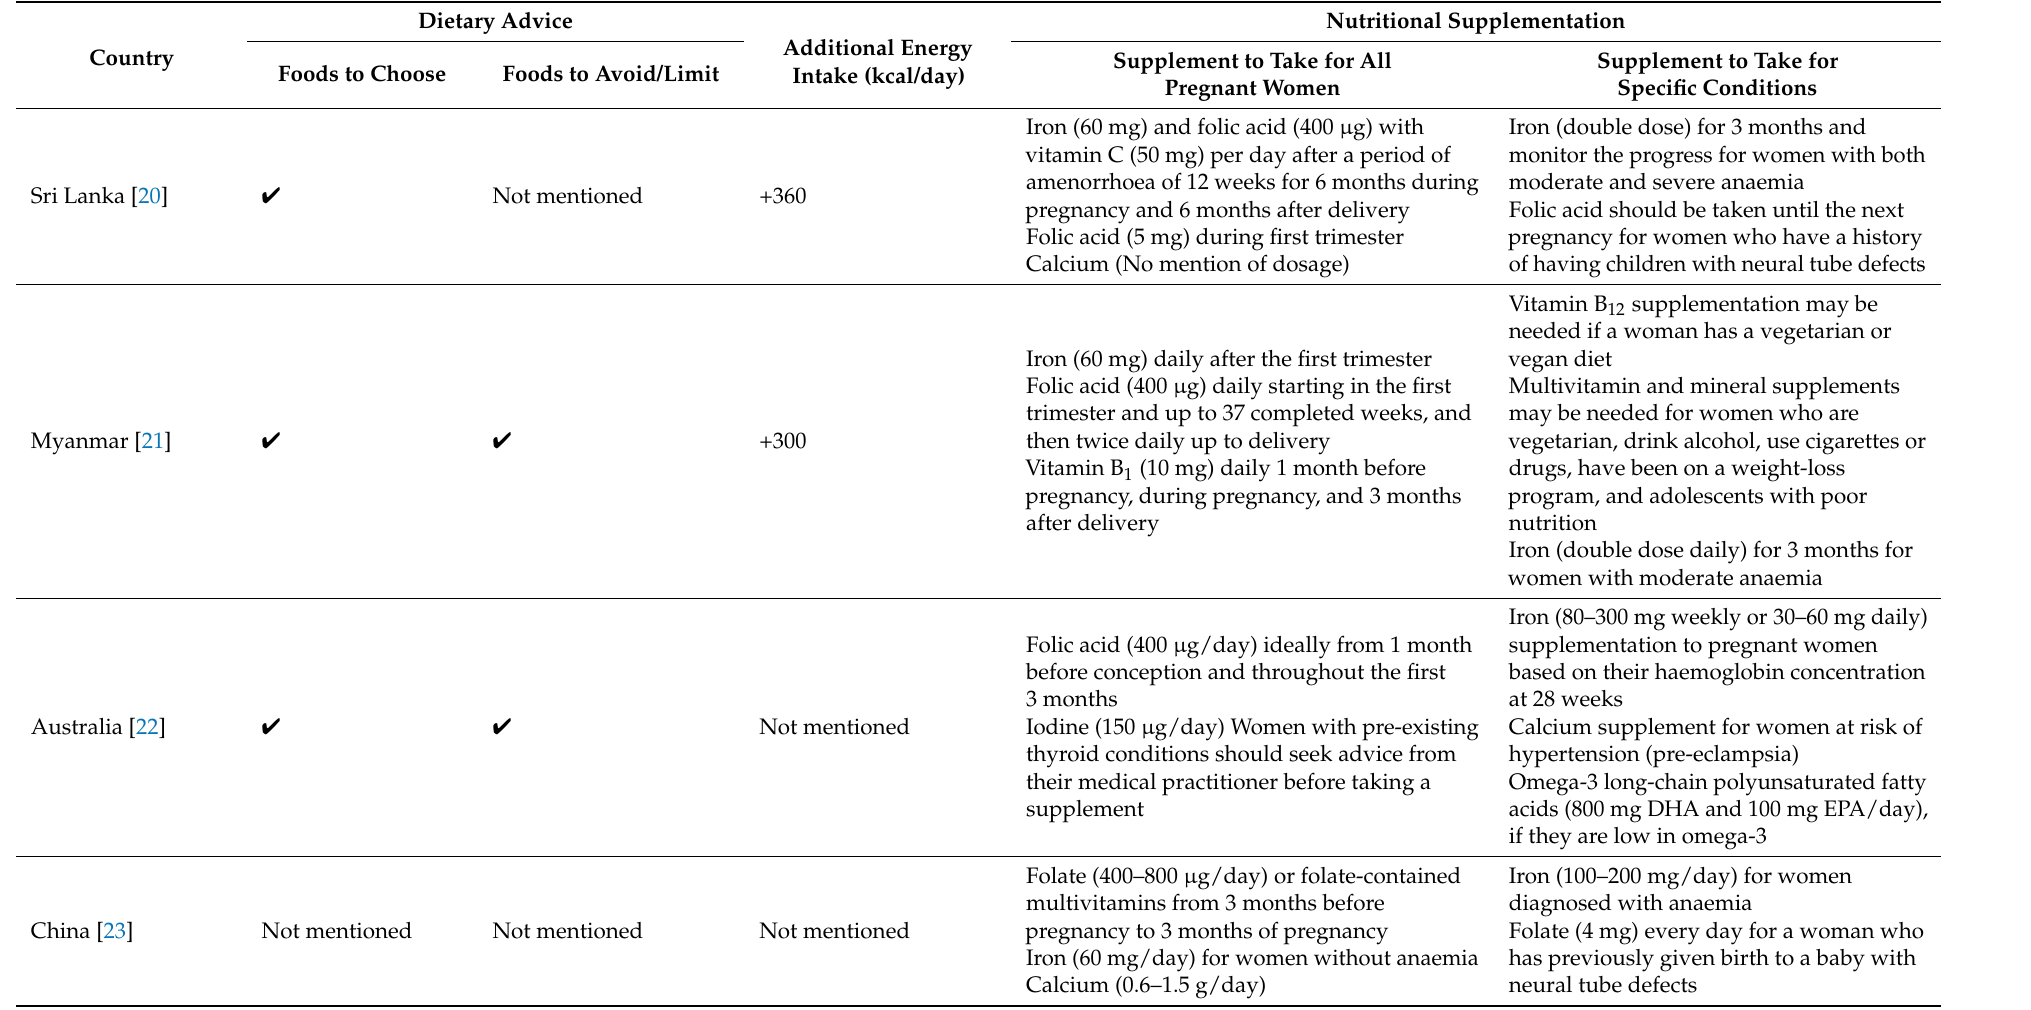
Table 5. Characteristics and spectrum of nutritional recommendations for pregnancy in the CPGs included in this